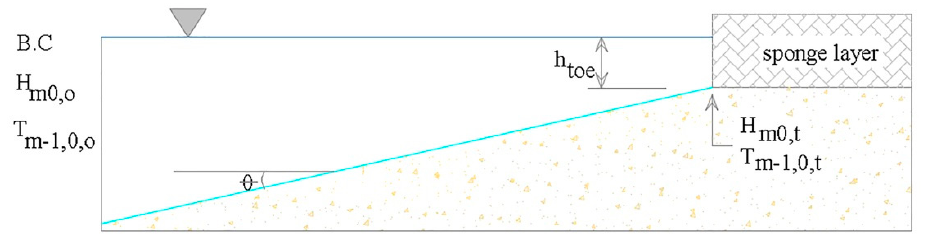
Figure 3. Wave parameters at toes in SWASH model for case studies.